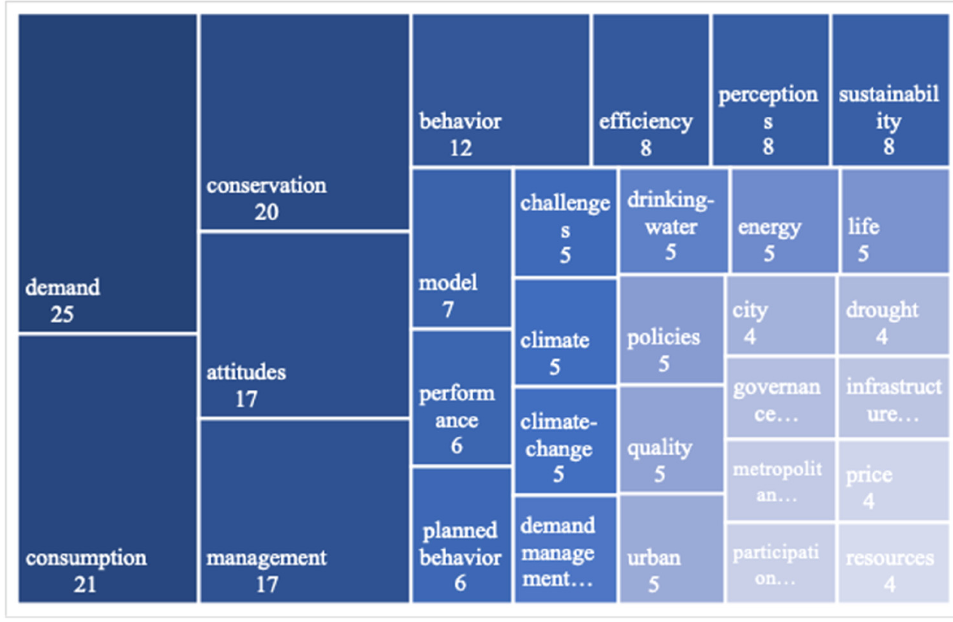
Figure 3. Most common keywords.